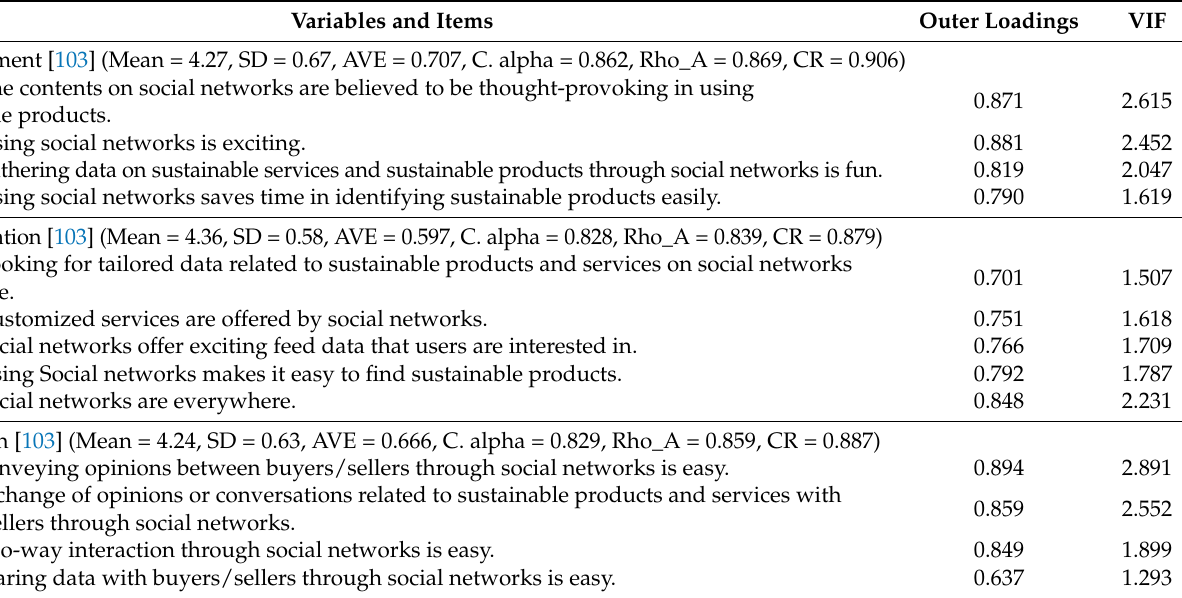
Table 1. Measurement